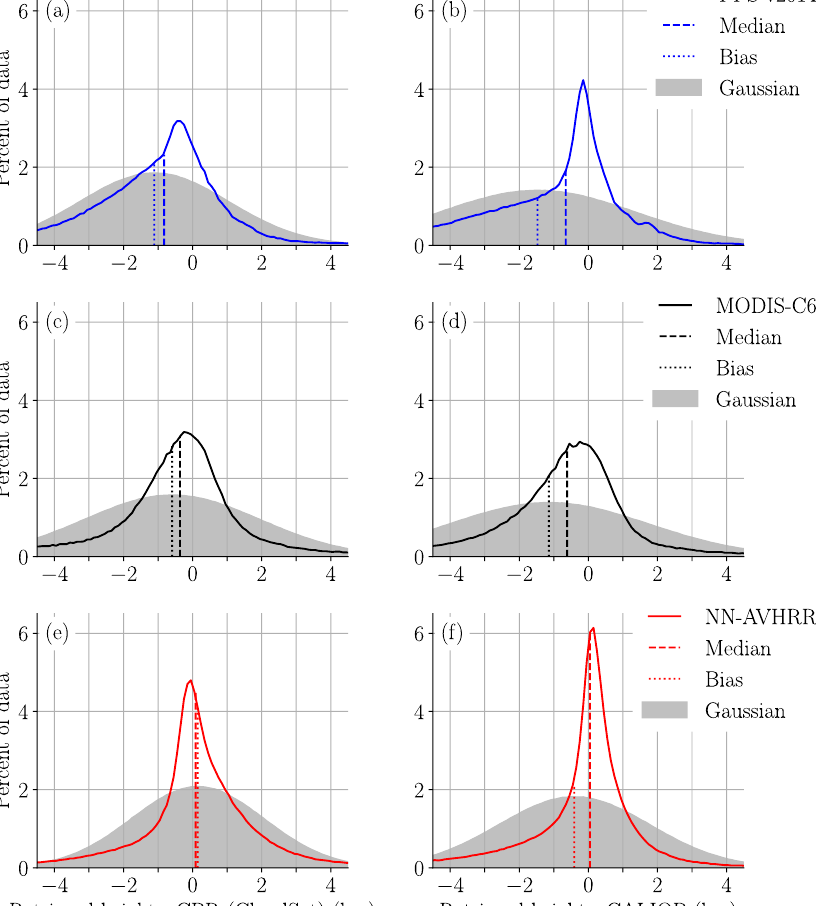
Figure 5. Error distribution compared to CPR (CloudSat) (a, c, e) and CALIOP (b, d, f) with biases and medians marked. The percent of data is calculated in 0.1km bins. The final validation dataset (see Table 1) where all algorithms had a height reported is used. Note that the values on the y axis are dependent on the bin size. The peak at 6% for NN-AVHRR in (f) , means that 6% of the retrieved heights are between the CALIOP height and the CALIOP height + 0.1km. The Gaussian distribution with the same bias and standard derivation is shown in